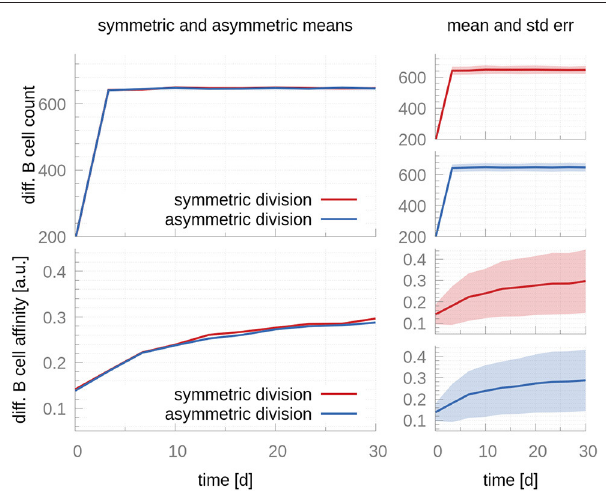
FIGURE 4 | A comparison between symmetric and fully asymmetric distribution of antigen during centroblast division. Top row shows the mean (Left) and mean plus standard error (Right) of the total differentiated GC output in the symmetric and asymmetric scenarios. In the former, 50% of the antigen goes to each CB daughter cell after each division; in the latter, 100% of the antigen goes to a single daughter cell. The bottom row reports the affinity of the differentiated GC cells. Differences between both scenarios are not significant both in terms of the total cell counts and the affinity of differentiated B cells. Since the number of differentiated cells is a discrete number, its standard deviation cannot be evaluated by taking a snapshot at a specific time. Instead, we accumulate the cells leaving within 3-day-intervals, as in the experimental data we fit the model to Weisel et al. ( 17). These intervals cause the sharp turn at day